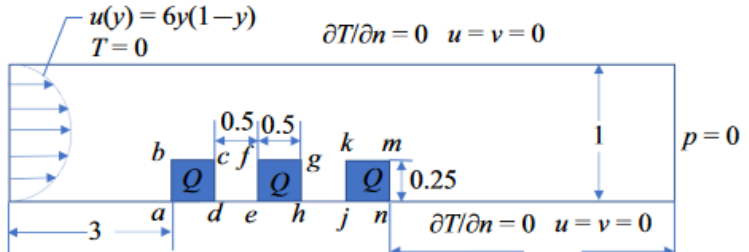
Figure 1. Geometric information about the forced convection cooling zone and rectangular block, the location of the monitoring points on the rectangular block, and the velocity, pressure and temperature boundary conditions of the zone.